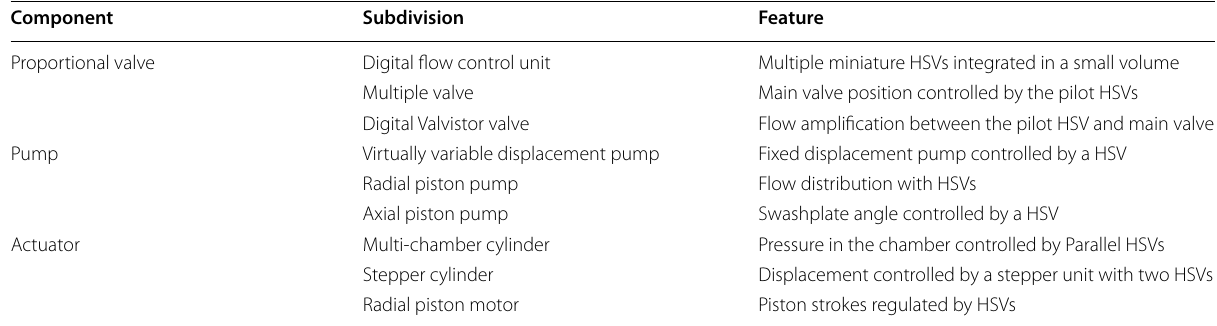
Table 4 Summary of the digital hydraulic components with HSVs